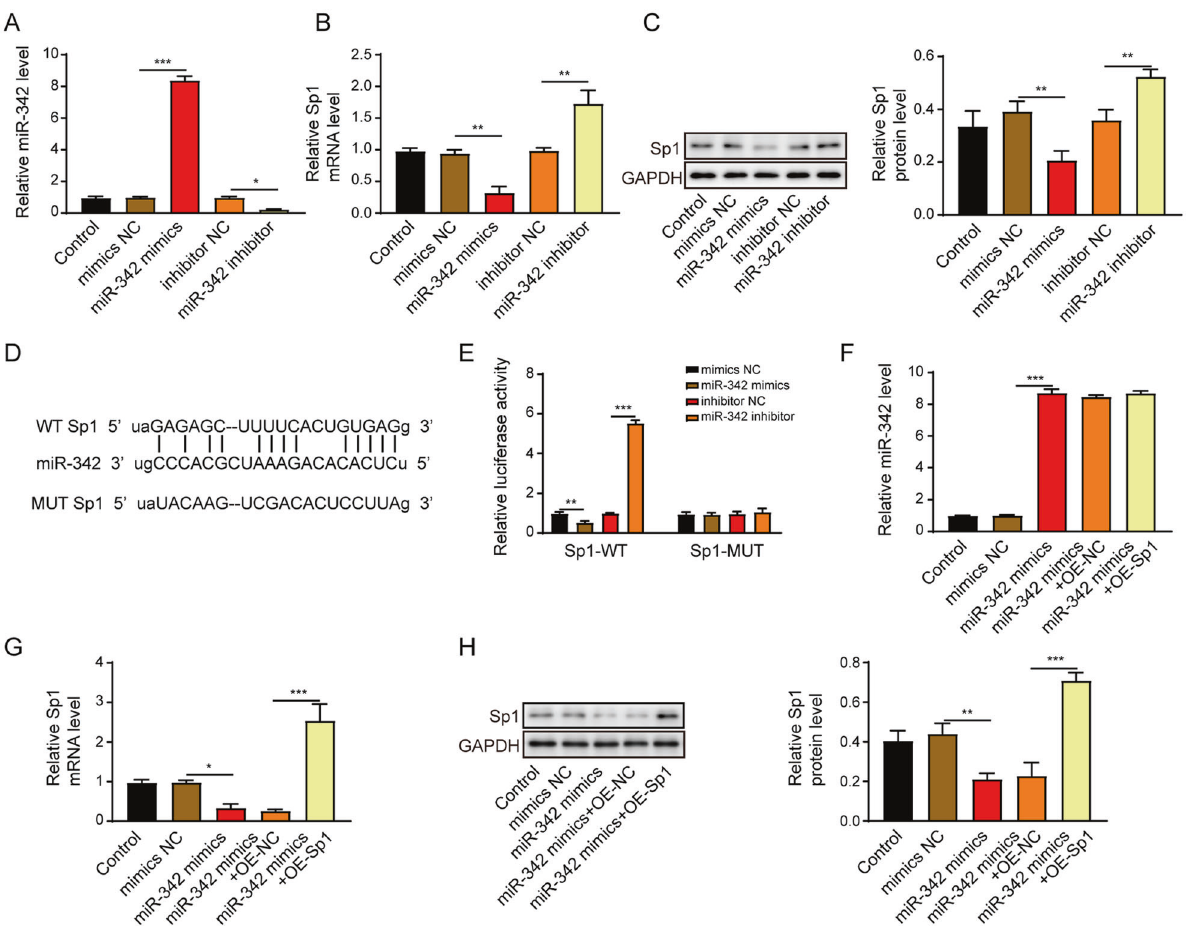
Fig. 7 MiR-342 directly suppresses Sp1 expression in LX-2 cells. A The miR-342 expression level in LX-2 cells was assessed via qRT-PCR. B , C Sp1 mRNA ( B ) and protein ( C ) levels were determined using qRT-PCR and western blot, respectively. D Schematic diagram of the miR-342 binding sites on Sp1. E The dual-luciferase activity of the Sp1-WT and Sp1-MUT in LX-2 cells transfected with miR-342 mimics or miR-342 inhibitor. F The miR-342 expression level in LX-2 cells was assessed via qRT-PCR. G , H Sp1 mRNA ( G ) and protein ( H ) levels were determined using qRT-PCR and western blot, respectively. * p < 0.05; ** p < 0.01; *** p <